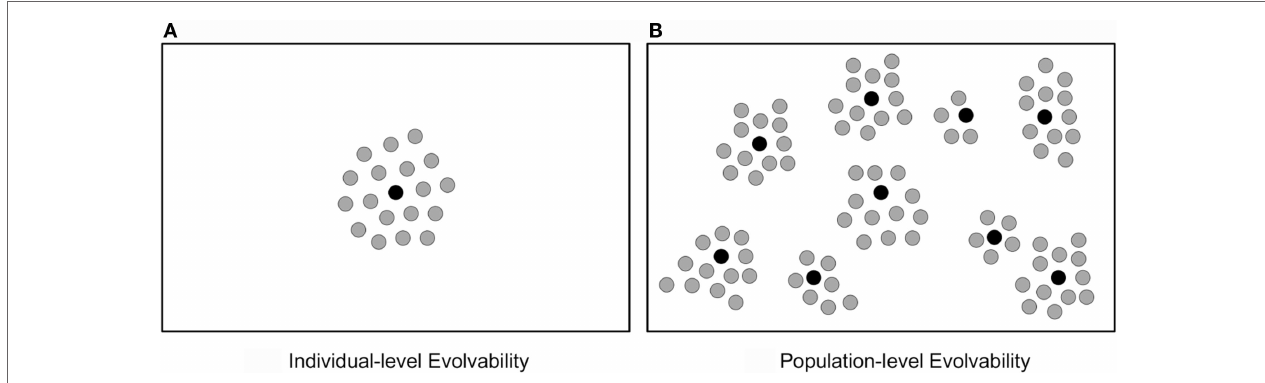
FiGUre 1 | encouraging evolvability on different levels of organization . Both figures show an abstract space of phenotypes, where black circles indicate individuals and gray circles indicate phenotypes accessible within an individual’s mutational neighborhood. Thus, a more expansive radius of gray circles indicates a more evolvable individual. When considering (A) individual-level evolvability, its maximization is achieved by a single highly evolvable individual. However, when considering (B) population-level evolvability, its maximization is achieved by accumulating a diversity of complementarily evolvable individuals. In this way, encouraging population-level evolvability is a more productive goal, because a broader set of phenotypes can be reached through mutations of the resulting population than through mutations of any singularly evolvable